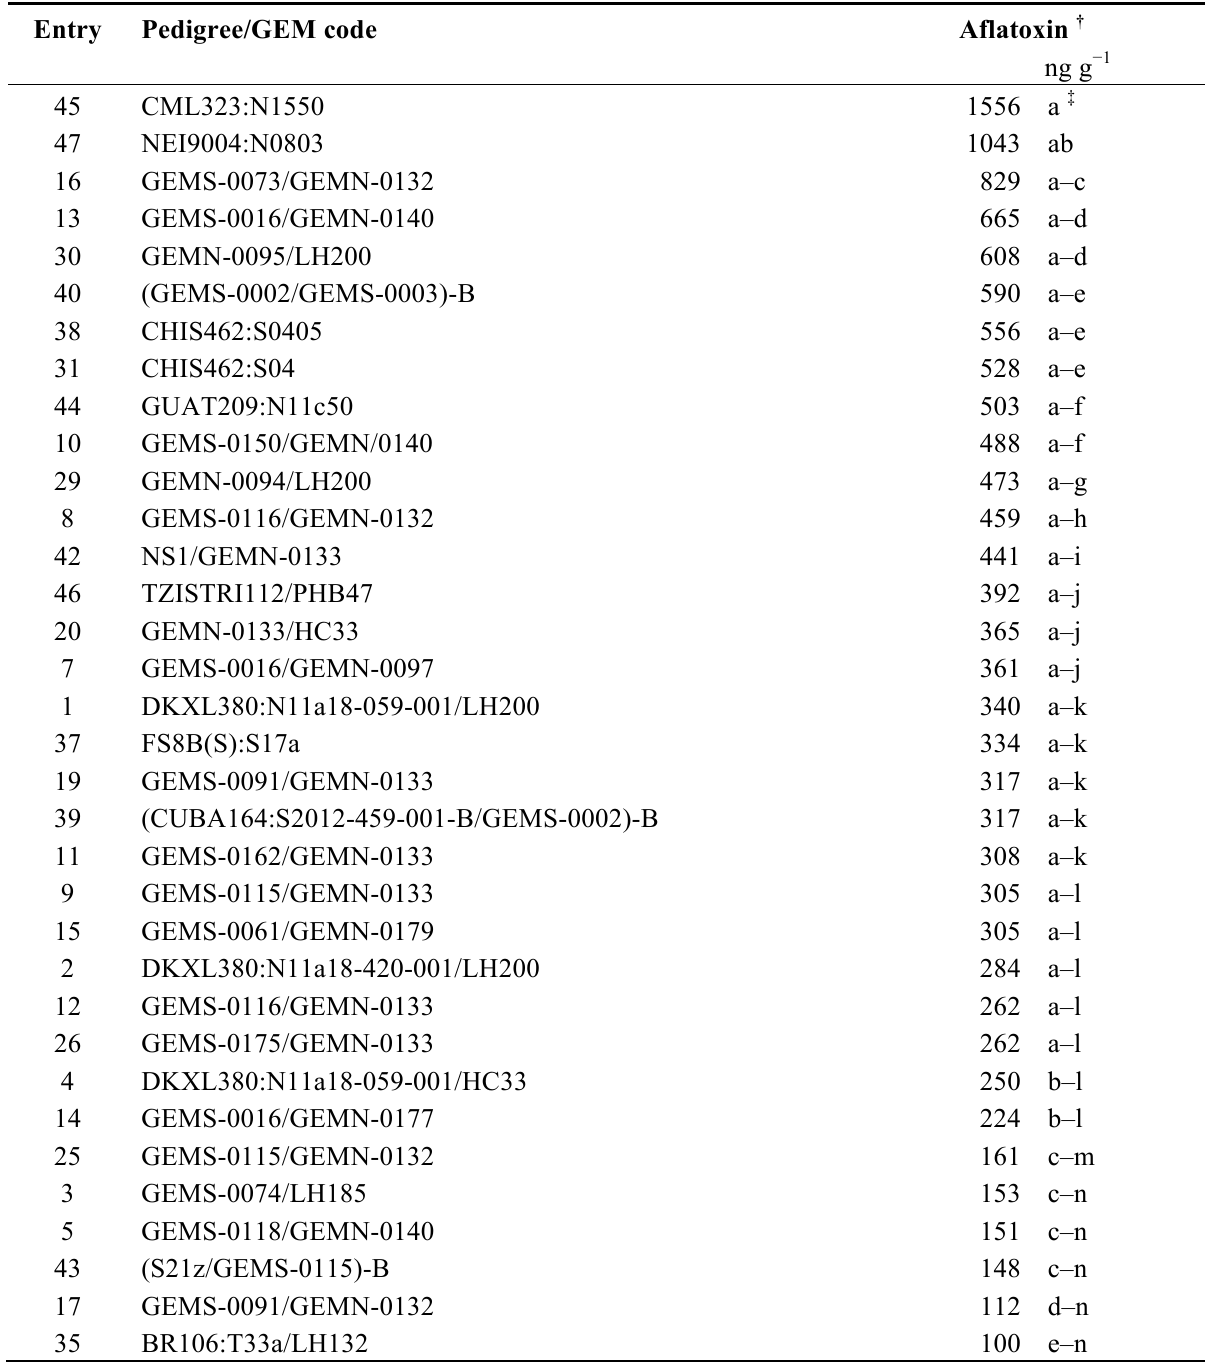
Table 3. Aflatoxin evaluation of corn hybrids and breeding crosses in